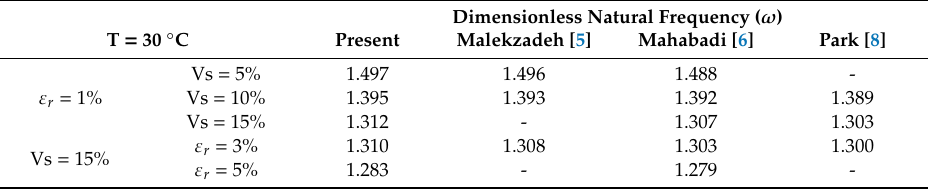
Figure 3. Dimensionless natural frequency vs. temperature. Table 2. Comparison of dimensionless natural frequencies.